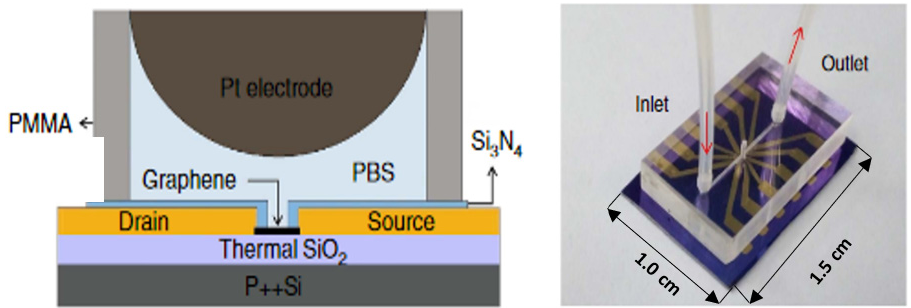
Figure 18. Scheme (on the left ) and photograph (on the right ) of label-free FET genosensor for simultaneous detection of six different DNA sequences. Adapted with permission from Xu et al. [118] (under the terms and conditions of the Creative Commons CC BY License 4.0).